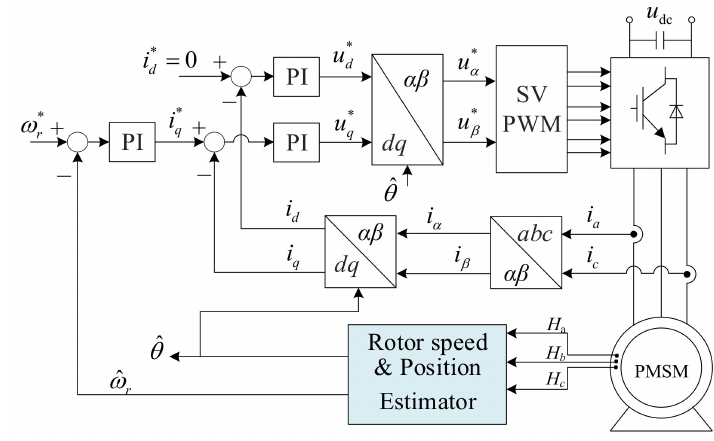
Figure 1. Block diagram of PMSM FOC based on Hall-effect sensors.